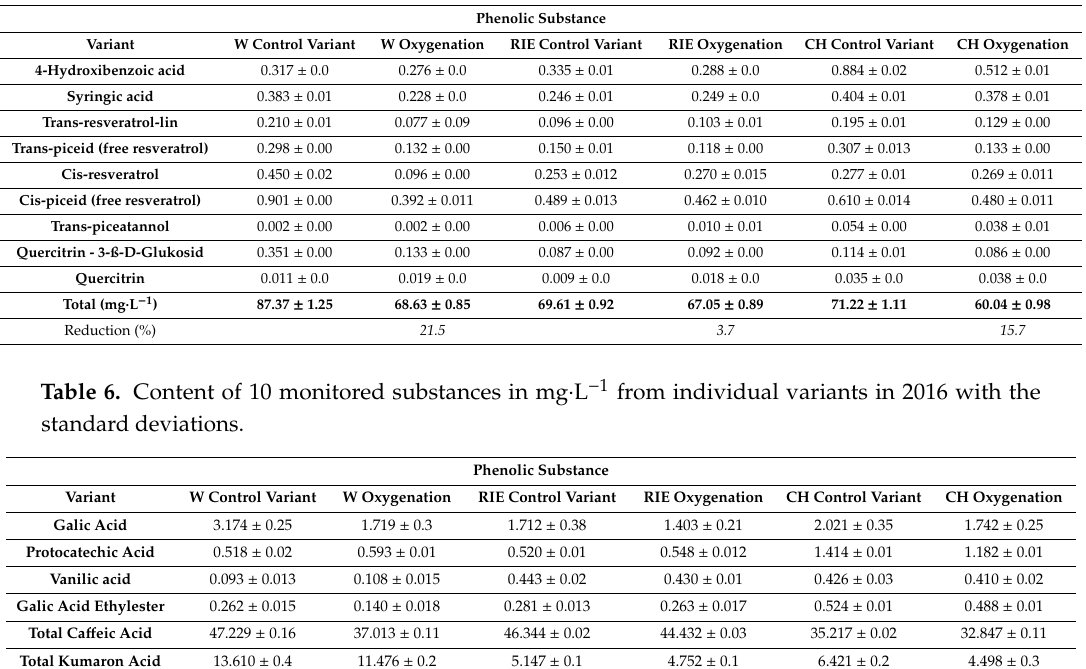
Table 5. Content of nine other monitored phenolic substances in mg · L − 1 from individual variants in 2015. The total amount of all 19 monitored substances and their percentage reductions from the variants that were processed by oxygenation in comparison with the control variant with the standard deviations.